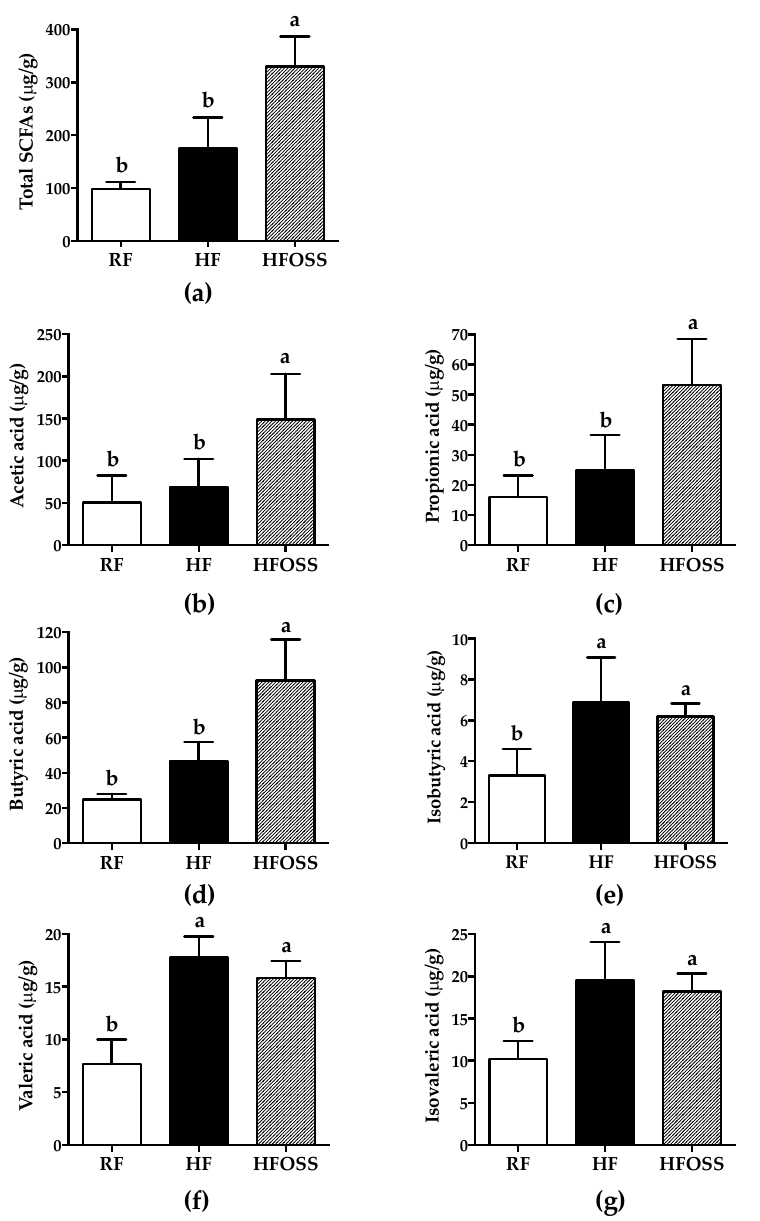
Figure 5. Fecal short-chain fatty acids (SCFAs) concentrations of mice fed a regular-fat diet (RF), high-fat diet (HF), and high-fat diet supplemented with OS starch (HFOSS). ( a ) Total SCFAs, ( b ) acetic acid, ( c ) propionate acid, ( d ) butyric acid, ( e ) isobutyric acid, ( f ) valeric acid, and ( g ) isovaleric acid. Values with different letters indicate significant differences between groups ( p < 0.05).